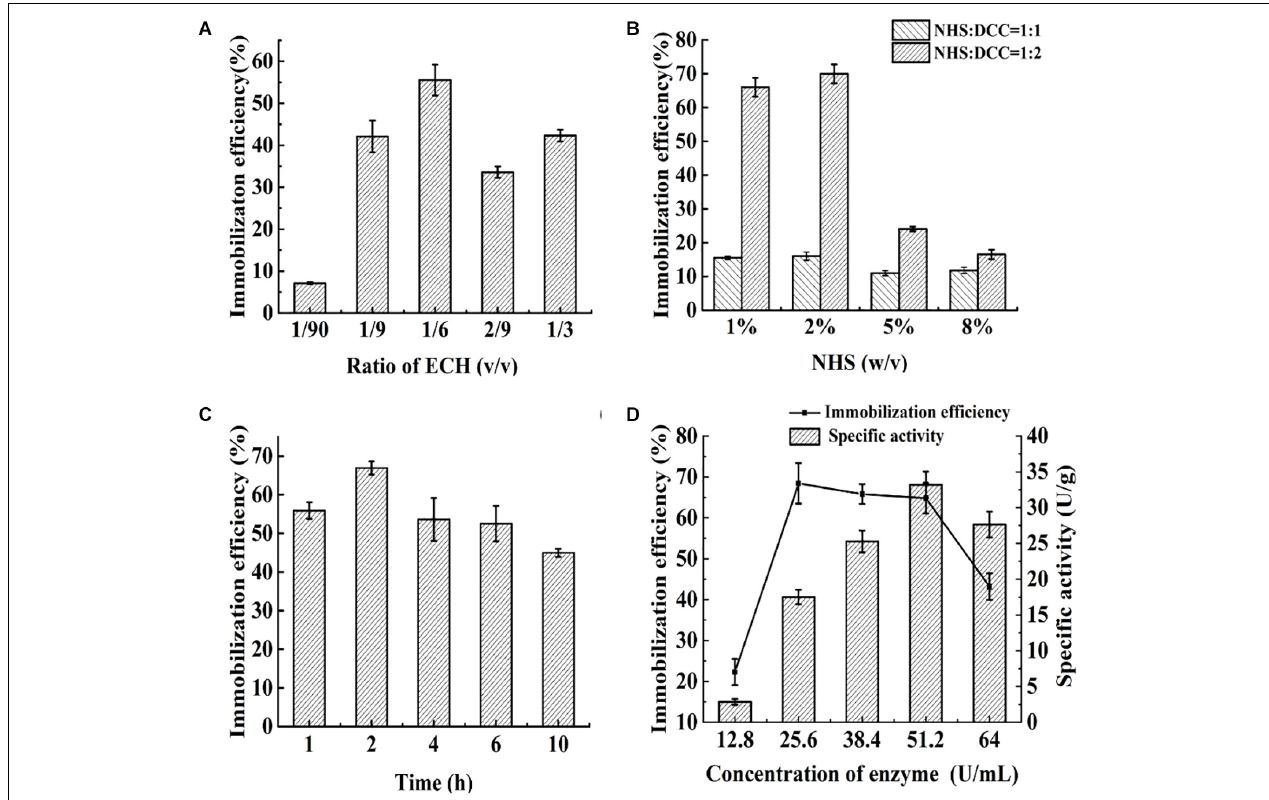
FIGURE 2 | (A) Effect of the ratio of epichlorohydrin (ECH) (v/v) on immobilization efficiency: varied from 1/90 to 1/3. (B) The effect of N-hydroxysuccinimide (NHS) dosage (w/v) and ratio of NHS/N,N (cid:48) -dicyclohexylcarbodiimide (DCC) (v/v) on immobilization efficiency: varied from 1 to 8% and 1:1 to 1:2, respectively. (C) Effect of immobilization time on immobilization efficiency: varied from 1 to 10 h. (D) Effect of enzyme concentration on immobilization efficiency and specific activity: varied from 12.8 to 64